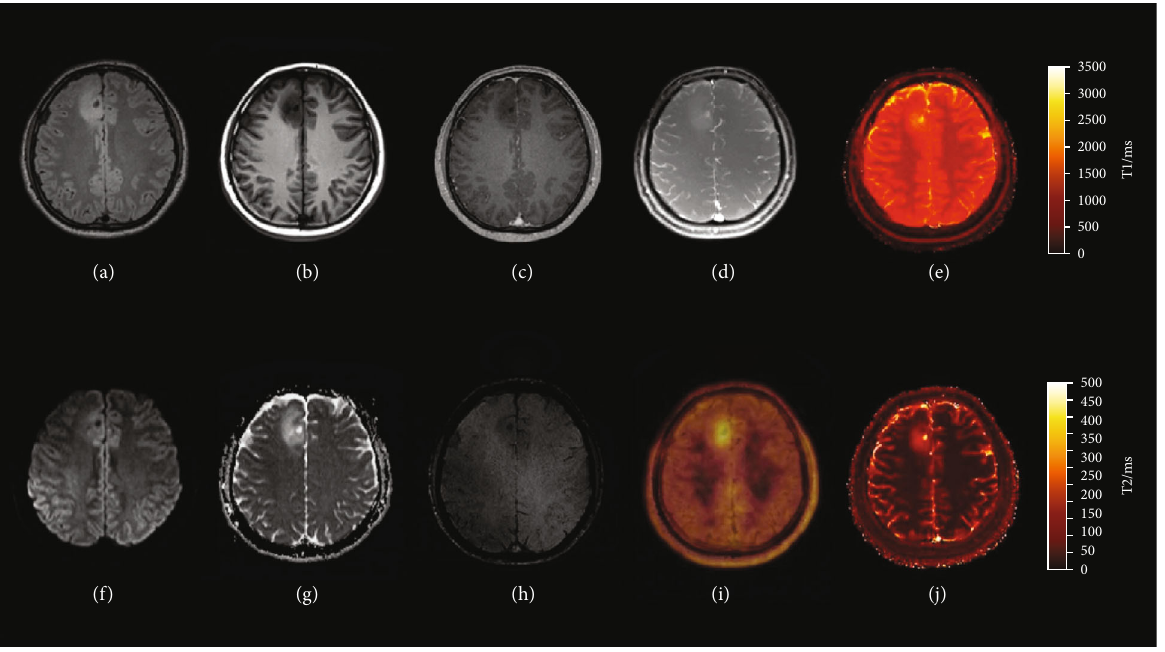
Figure 10: FET PET with MRI fi ngerprinting (MRF). Multiparametric 18 F-FET PET-MRI and MR fi ngerprinting of a patient with a low- grade (WHO II) astrocytoma. (a) 3D FLAIR SPACE (sampling perfection with application optimized contrasts using di ff erent fl ip angle evolution) image. (b) T1-weighted MRI. (c) Postcontrast T1-weighted MRI. (d) MRF M0. (e) MRF T1-weighted image. (f) B1000. (g) ADC. (h) SWI. (i) PET/postcontrast T1-weighted MRI fusion. (j) MRF T2-weighted image. Reproduced with permission from Figure 8 of Haubold et al.